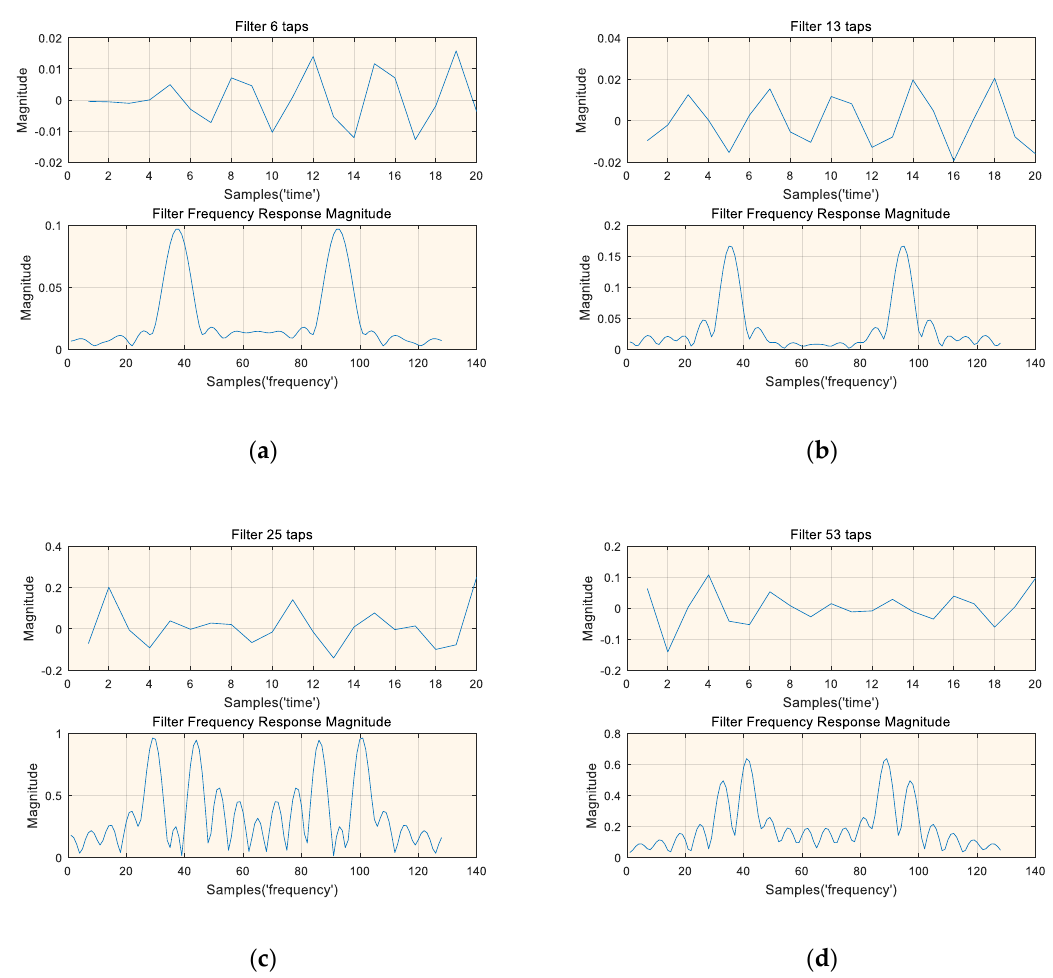
Figure 10. Time and frequency magnitude representations of four typical filters, ( a ) Time and frequency magnitude representations of filter 6 taps, ( b ) Time and frequency magnitude representations of filter 13 taps, ( c ) Time and frequency magnitude representations of filter 25 taps, ( d ) Time and frequency magnitude representations of filter 53 taps.